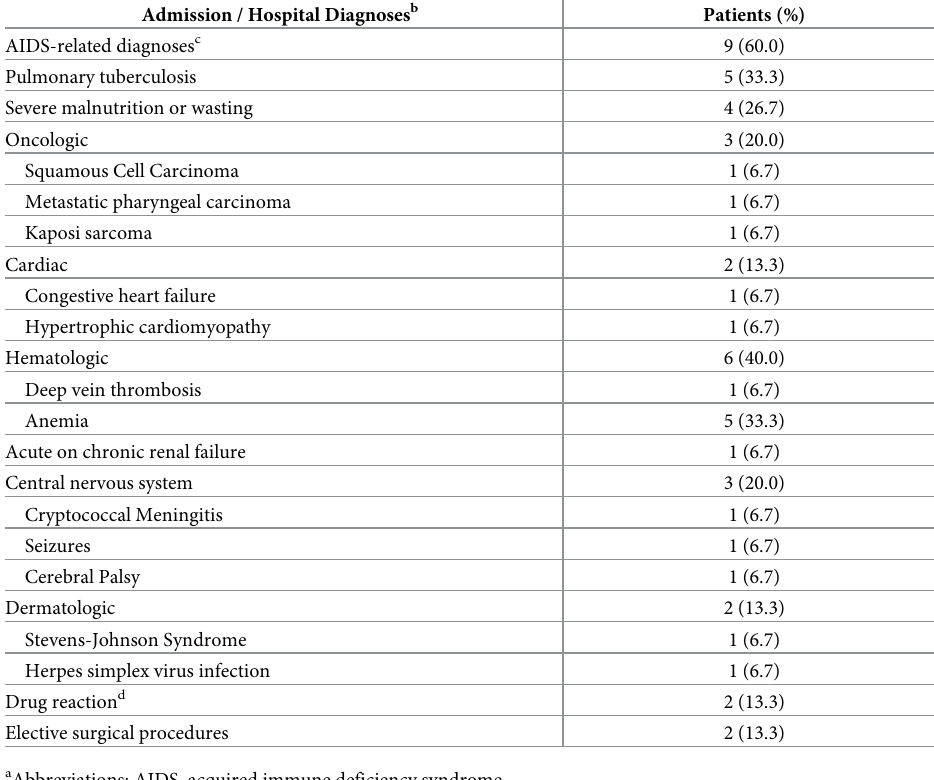
Table 2. Diagnoses given on admission or during hospitalization per medical team a